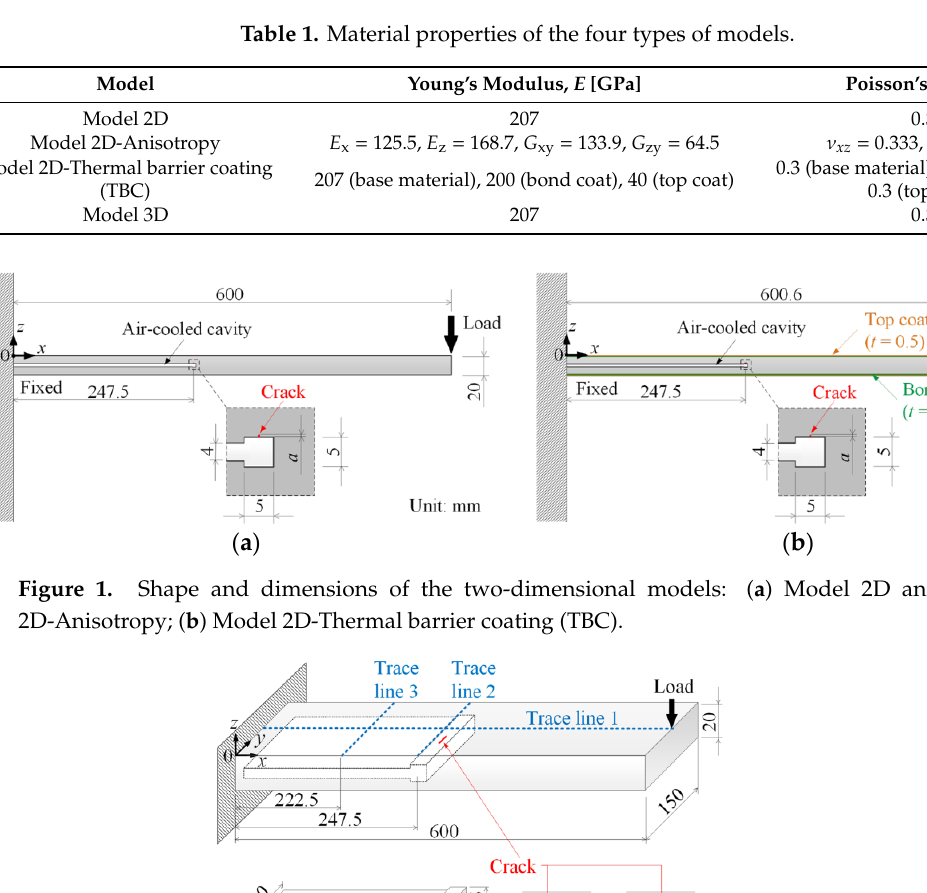
Table 1. Material properties of the four types of models.